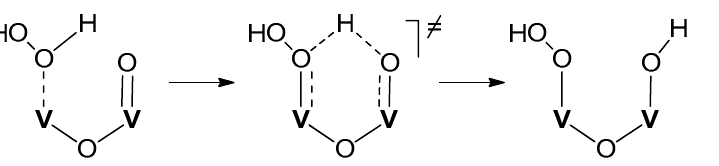
Figure 23. Proton transfer between two vanadium-containing fragments. Adapted from Ref. [158], Copyright (2011) with permission of American Chemical Society.